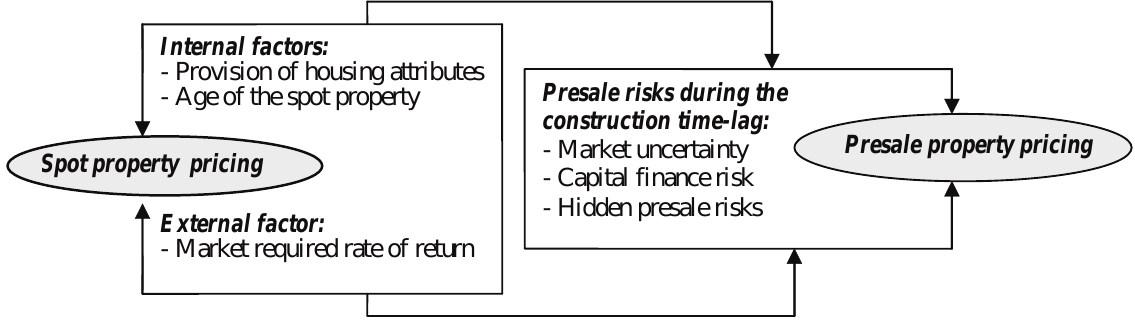
Figure 2. conceptual framework for pricing spot and presale properties source: Leung et al.